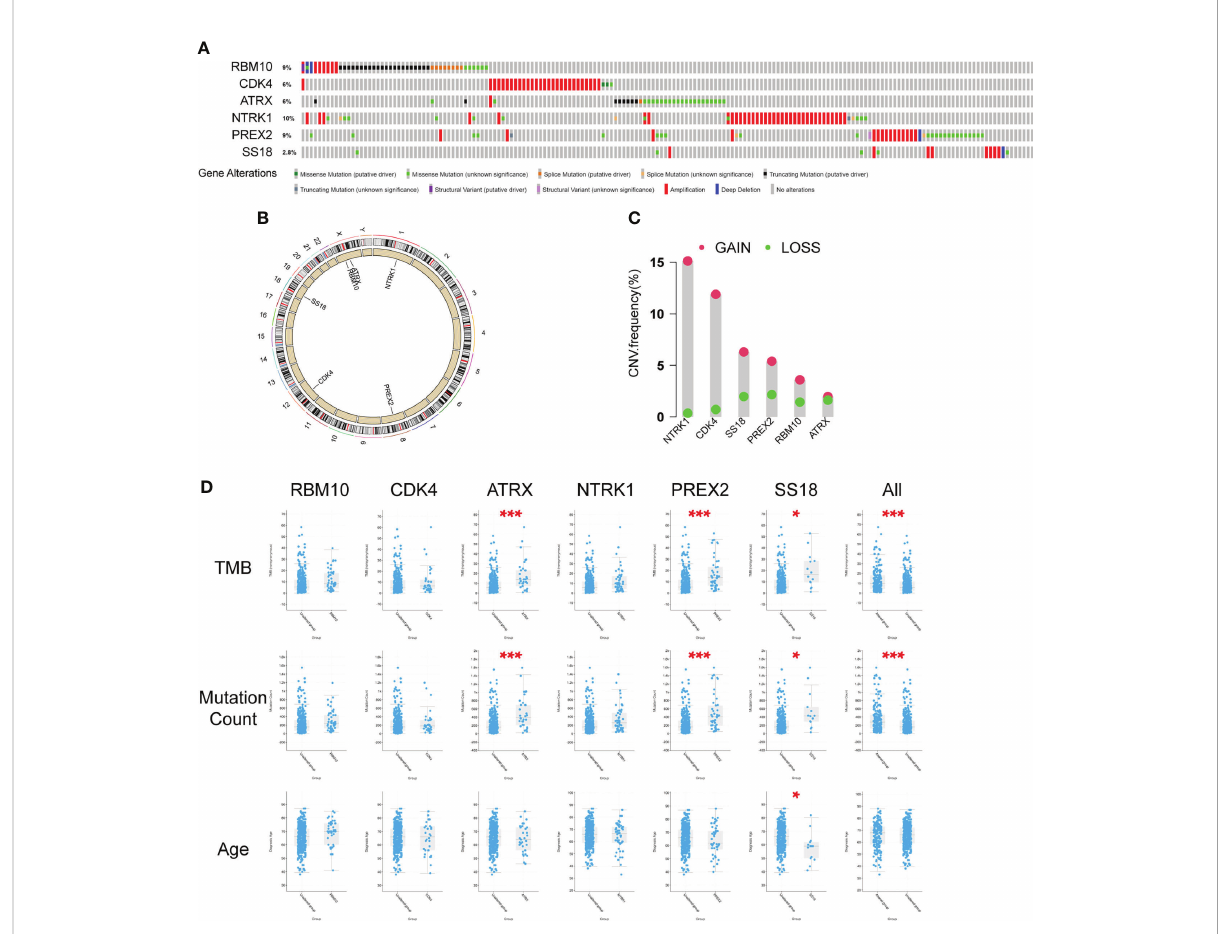
FIGURE 4 Characteristics of the six differently mutated genes. (A) Gene alterations obtained from cBioPortal database. (B) Gene location on chromosomes. (C) Gene CNV analysis using TCGA data. (D) Clinical correlation analysis of six genes using cBioPortal database. * p<0.05, ***